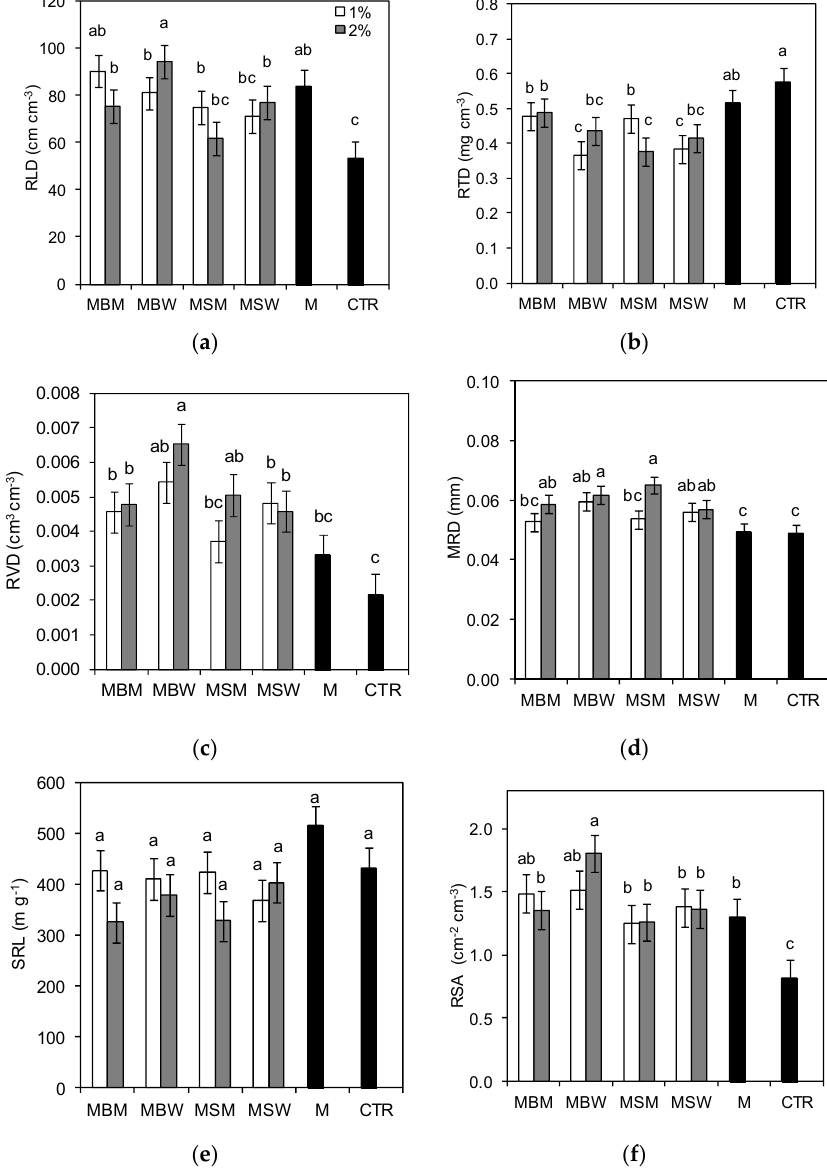
Figure 2. Root morphometric characteristics for soil amendment treatments ( ± standard error). Root length density (RLD) ( a ); root tissue density (RTD) ( b ); root volume density (RVD) ( c ); mean root diameter (MRD) ( d ); specific root length (SRL) ( e ); root surface area (RSA) ( f ). Treatments: wheat straw (MSW), wheat biochar (MBW), Miscanthus straw (MSM) and Miscanthus biochar (MBM), without organic amendments (M) and control treatment (CTR), without organic amendments and mineral fertilization. Di ff erent letters on the bars indicate significant di ff erences by the Bonferroni test ( p <